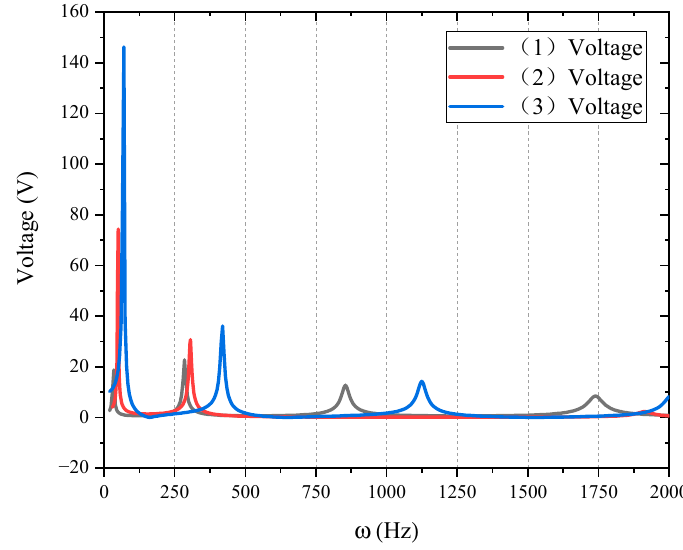
Figure 7. Control voltage of different piezoelectric patch position.